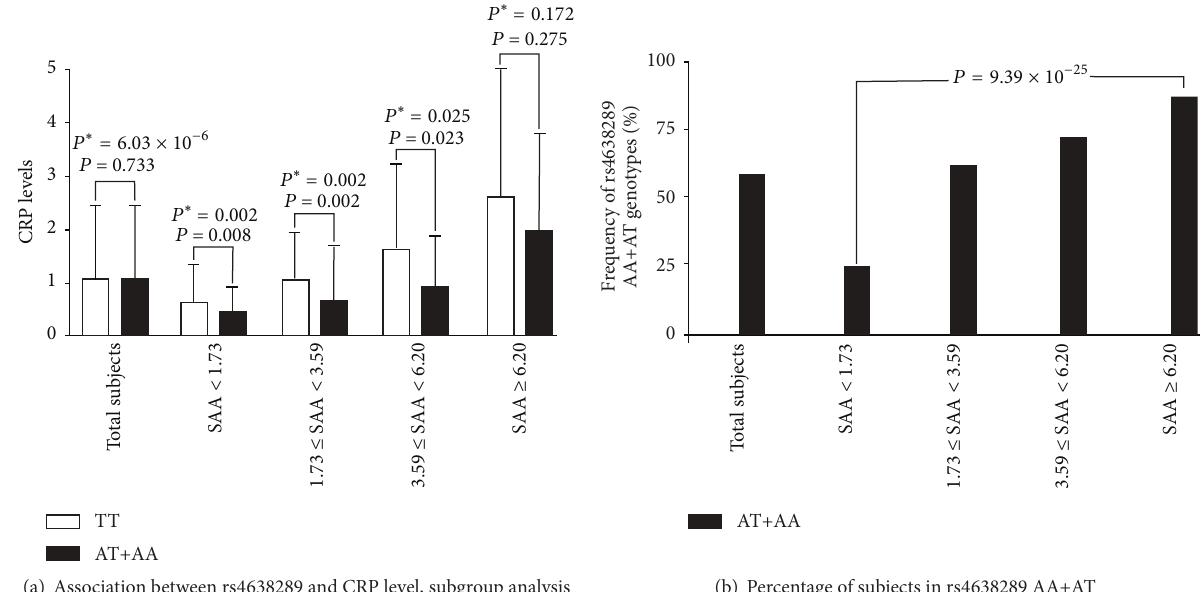
(b) Percentage of subjects in rs4638289 AA+AT Figure 1: (a) Subgroup analysis with SAA quartiles on the association between rs4638289 genotypes and CRP levels. (b) Frequencies of subjects with AA + AT genotypes of rs4638289 in each SAA quartile. 𝑃 value: adjusted for age, sex, body mass index, smoking, and medications for hypertension, diabetes mellitus, and dyslipidemia. 𝑃 ∗ value: further adjusted for SAA